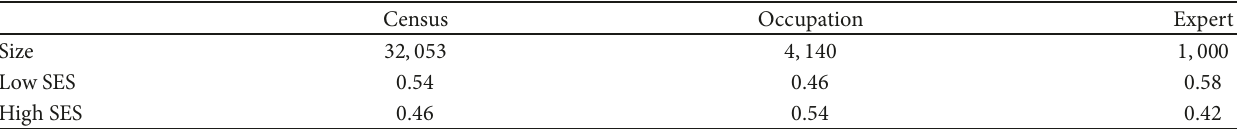
Table 1: Number of users and estimated fractions of low and high SES in each